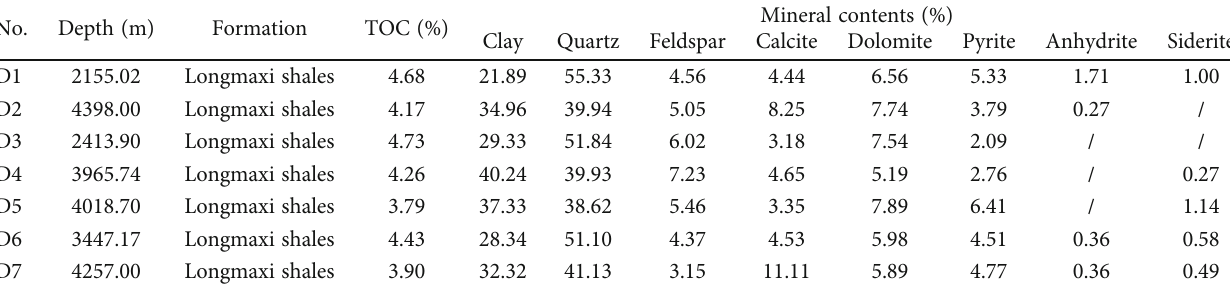
Table 1: Porosities and mineral contents of